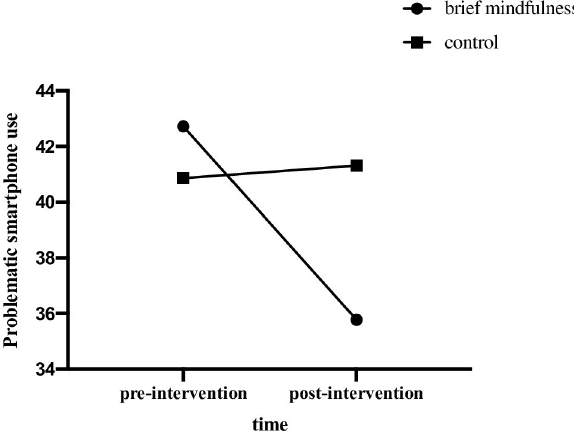
Fig 2. Problematic smartphone use scores of two groups in pre- and post- intervention.